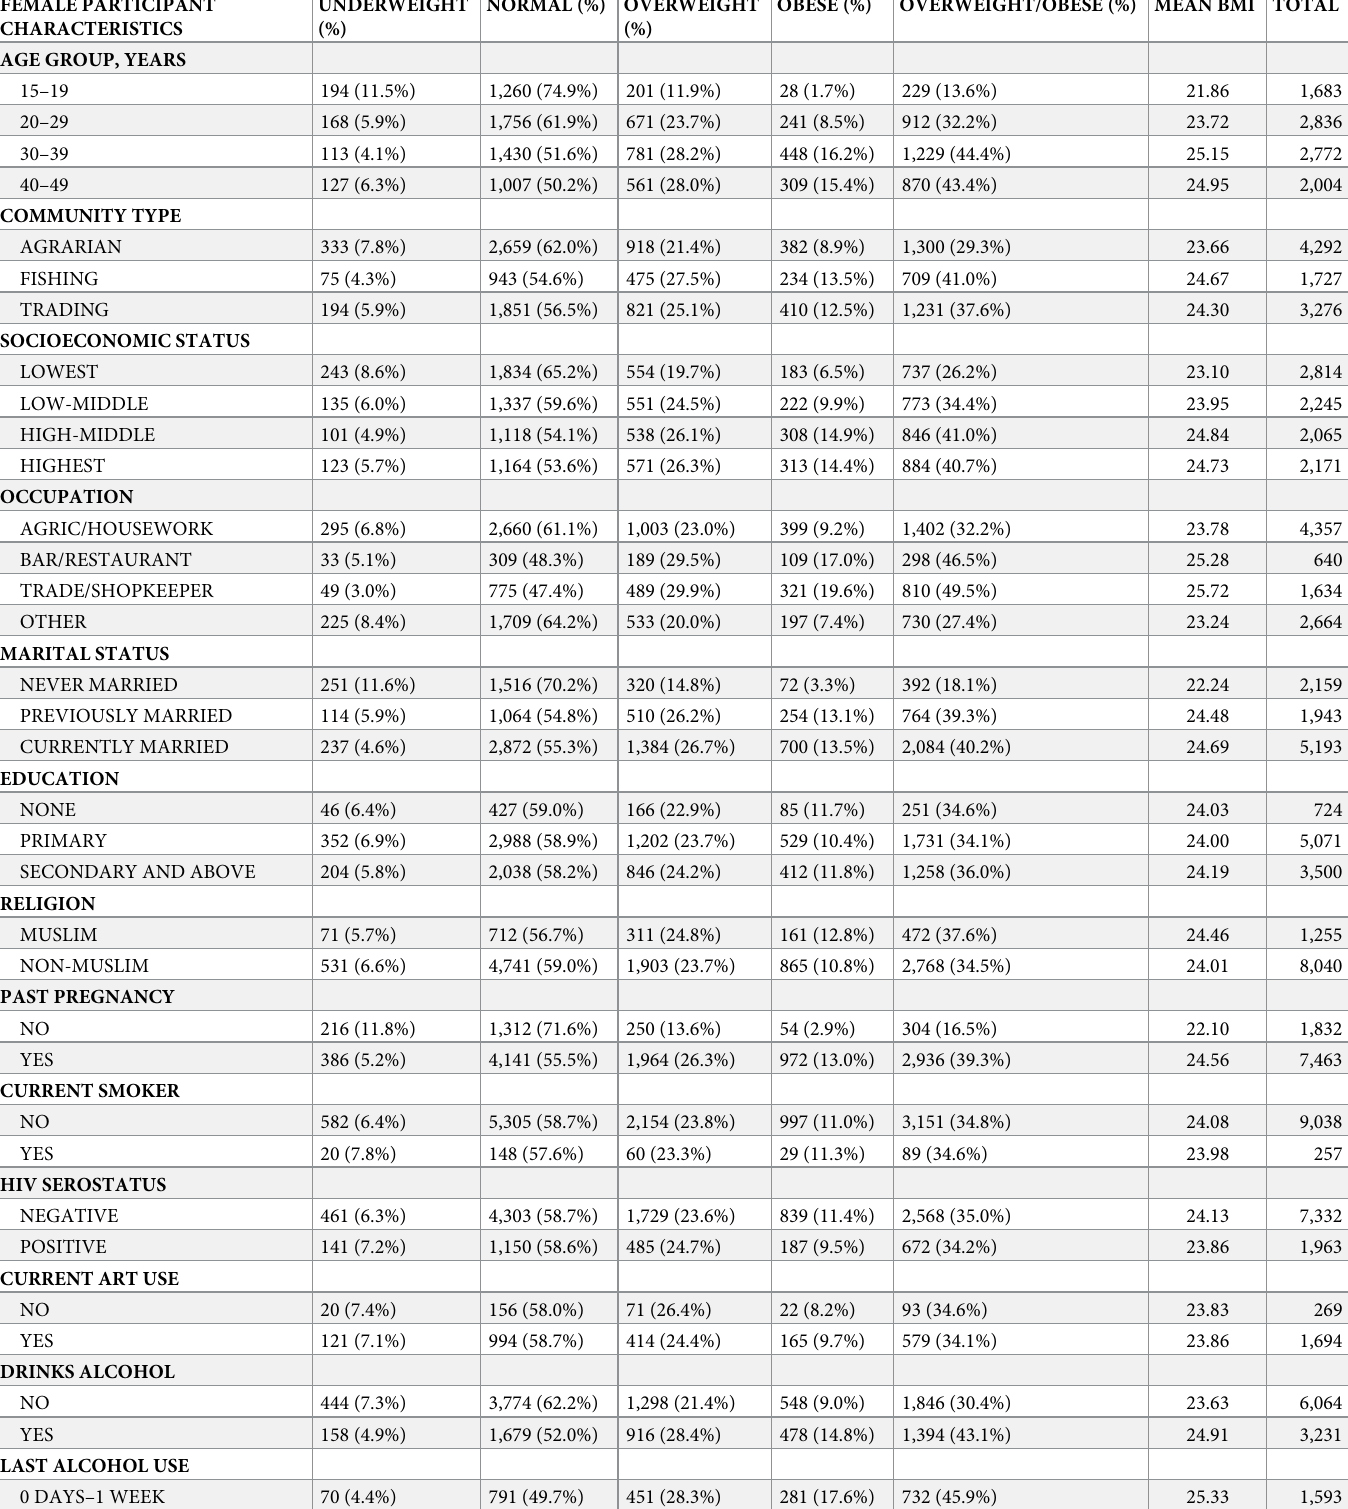
Table 2. Female population by BMI category over sociodemographic characteristics, including mean